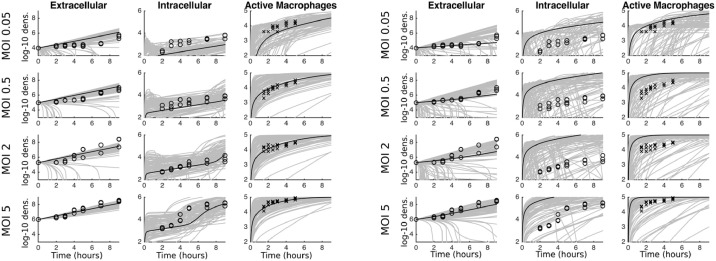
Similarly to Fig. 3, experimental data (circles for bacteria data, crosses for macrophage data) and mathematical model fits for four MOIs. In (a) all parameters are drawn from the posterior distributions in Fig. 2. In (b) all parameters are drawn from the prior distributions as in Table 2.